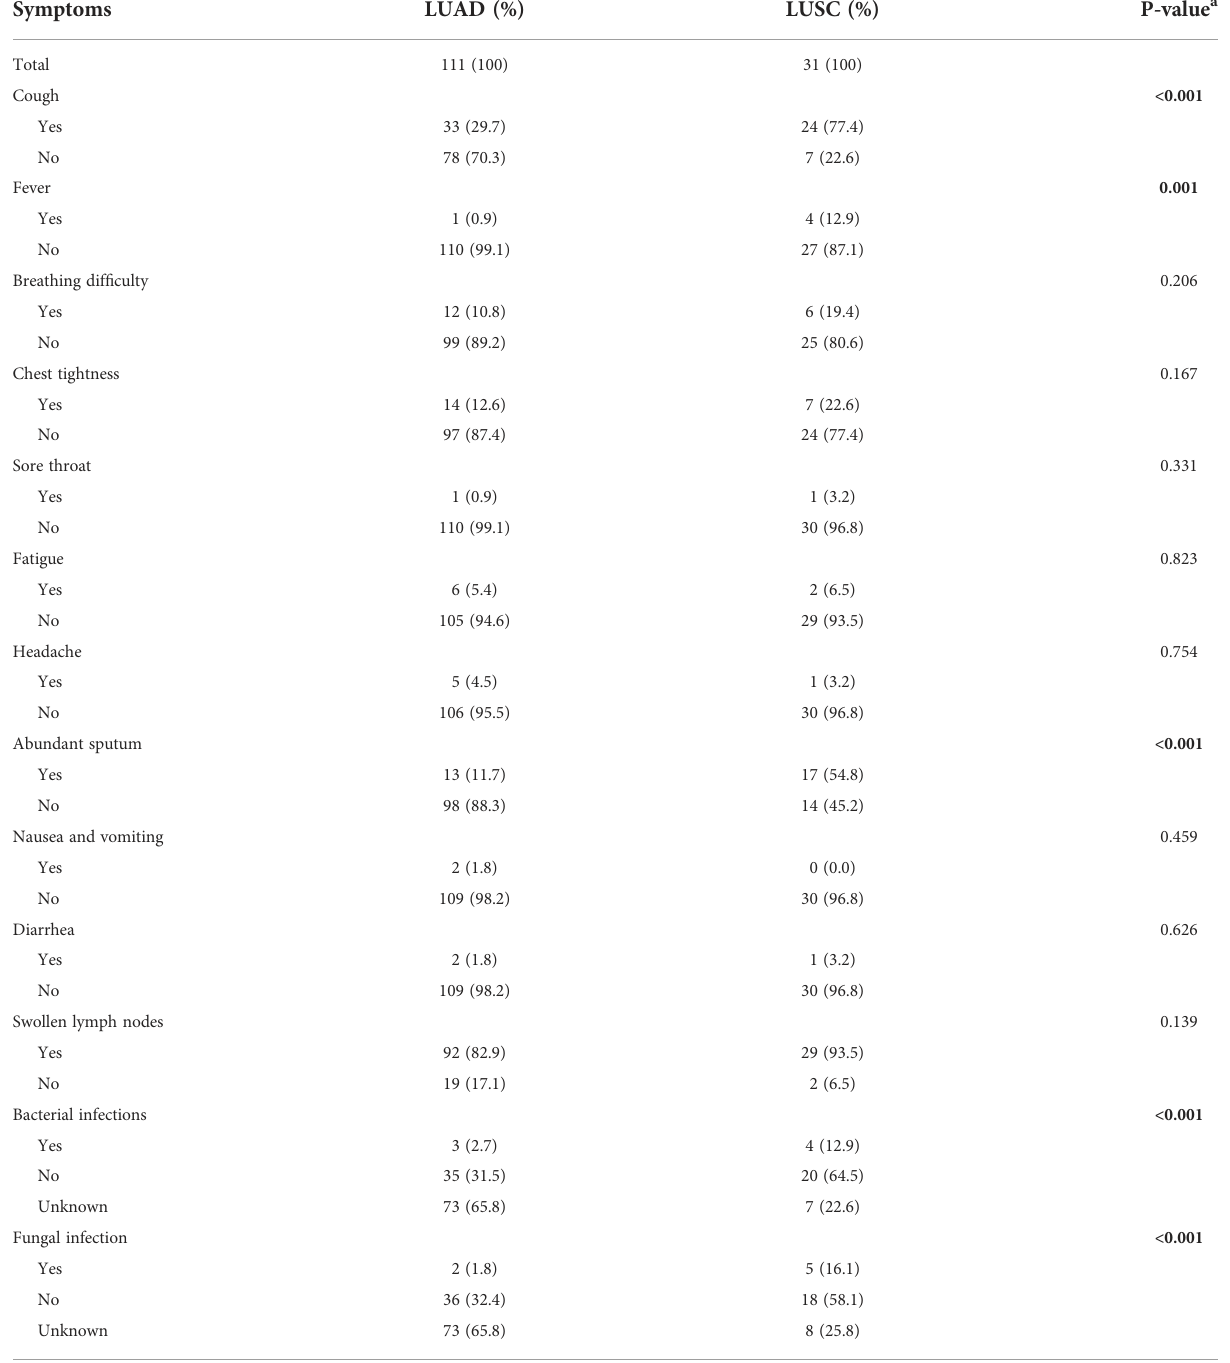
TABLE 2 Main symptoms of the